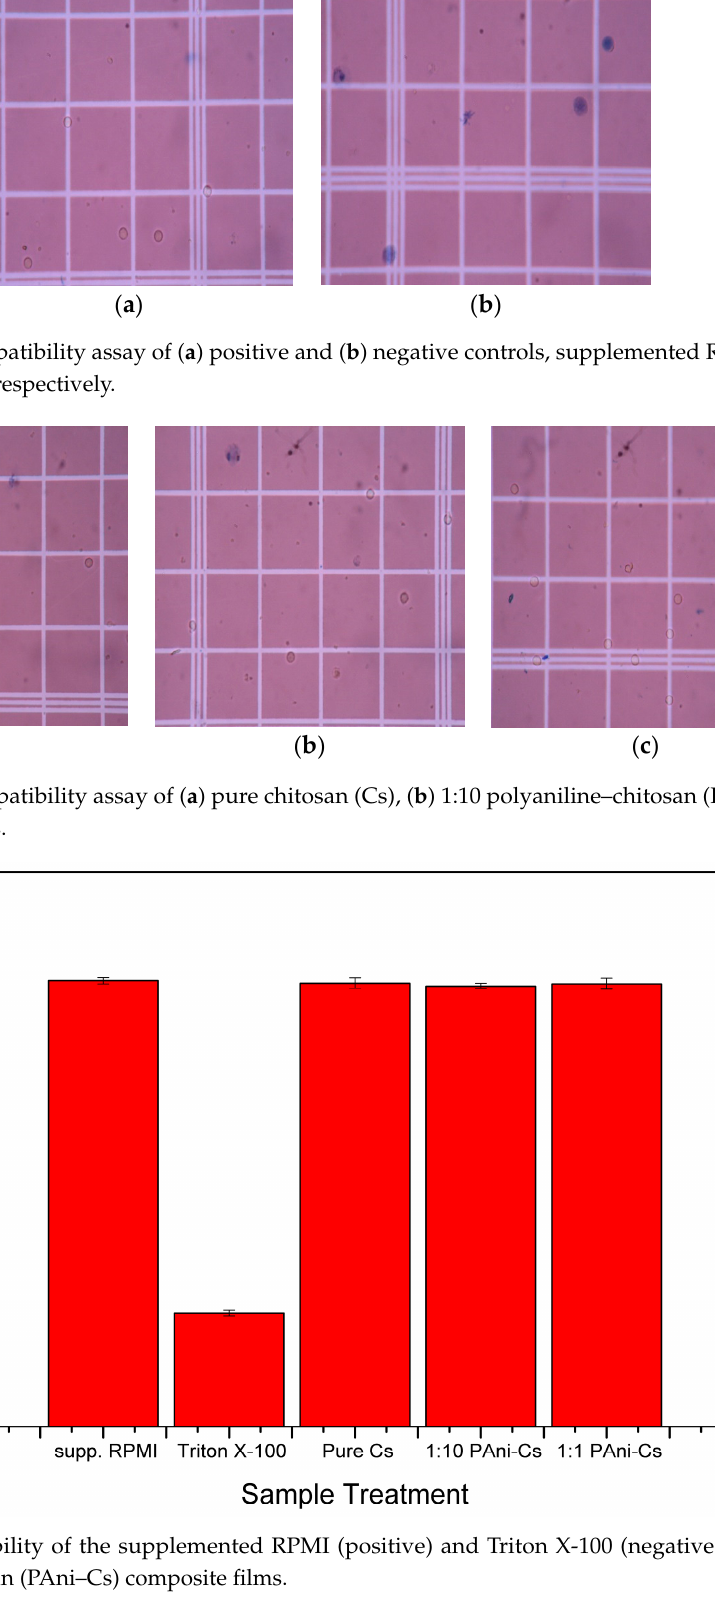
Figure 9. Cell viability of the supplemented RPMI (positive) and Triton X ‐ 100 (negative) and the polyaniline–chitosan (PAni–Cs) composite films.